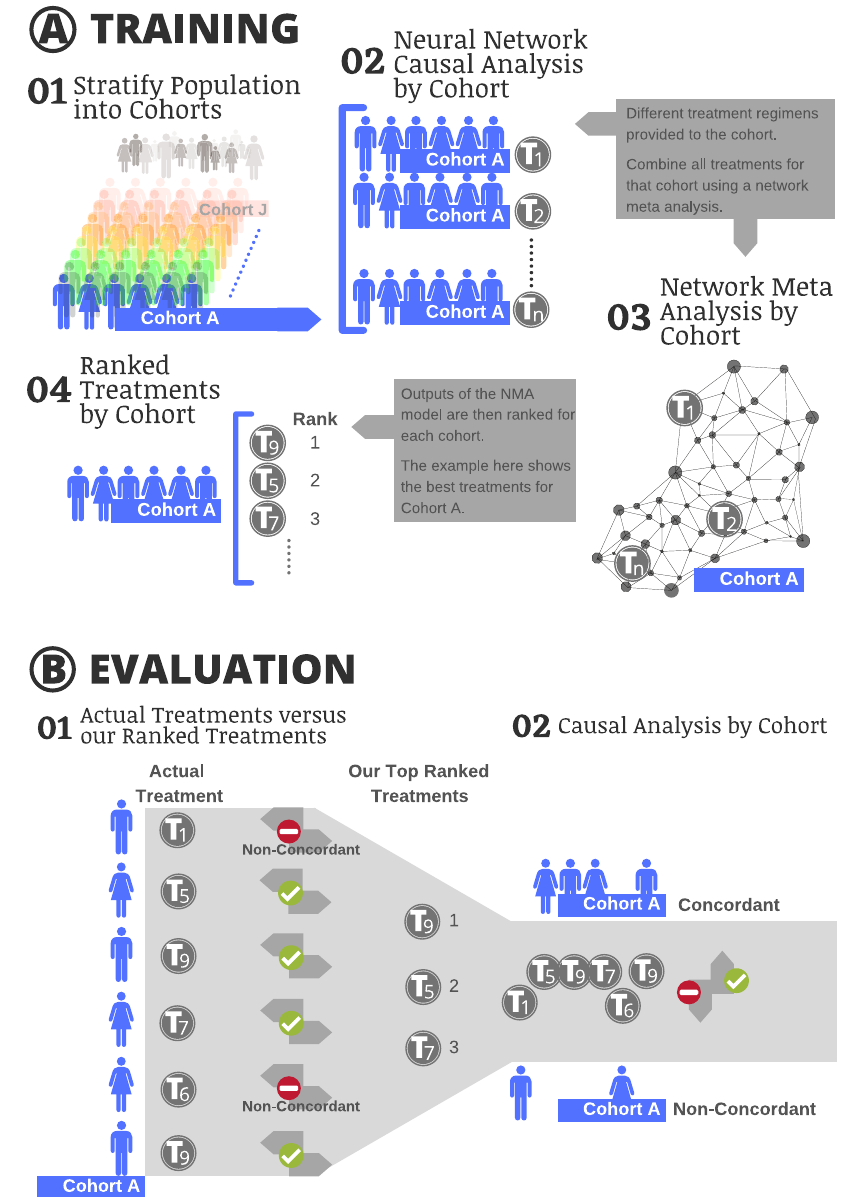
Fig. 2 | Schematic of ranking generation and analysis. Snapshots were split into training (80%) and test (20%) datasets. Snapshots were strati fi ed into 10 clinical cohorts based on age, number of comorbidities, and prior insulin use (Supple- mentary Table 1).For each clinical cohort, all treatments with cohort size>35 were selected and case-comparator observational studies were performed comparing every treatment with every other treatment using BCAUS, a neural-network-based propensity score model for causal inference. A densely connected network graph was constructed with treatments as nodes and edges connecting treatments via measuredAverageTreatment Effect(ATE) values. Bayesian NetworkMeta-Analysis (NMA) was performed to compute network-synthesized ATEs compared against a